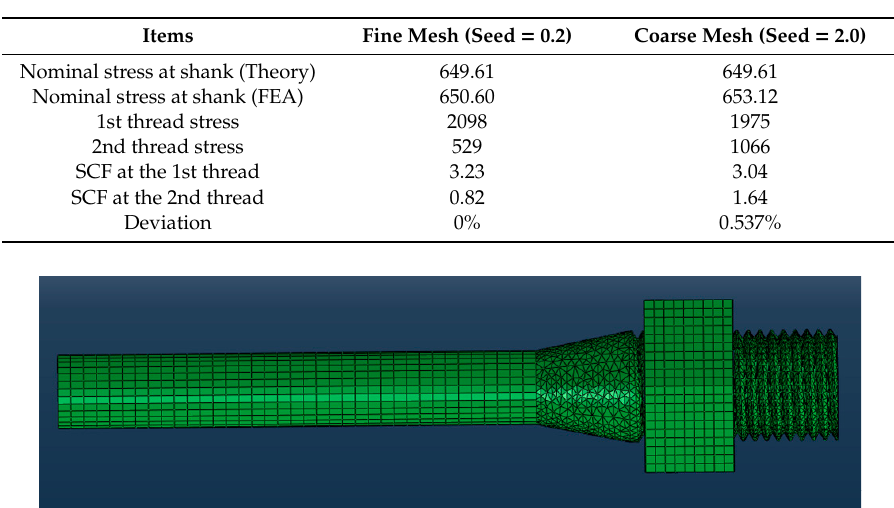
Figure 8. Mesh size distribution (2.0 mm for the body of bolt and nut, 0.2 mm for the thread/transition zone).